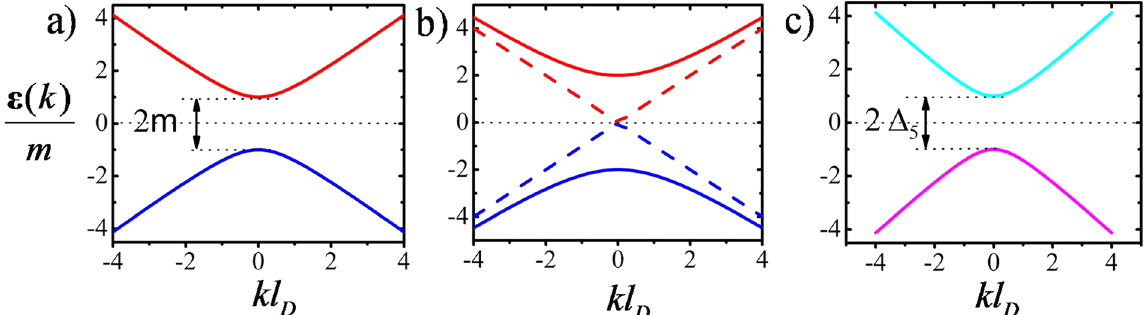
Figure 2. ( a ) Dispersion relation of 3DDM regime. ( b ) Gap closing and topological phase transition for one band whereas the other one remains trivial. ( c ) Dispersion relation of 3DDS regime. In these results we set E F = 0. The length scale l D = ħ / mv F is set by the energy gap of the